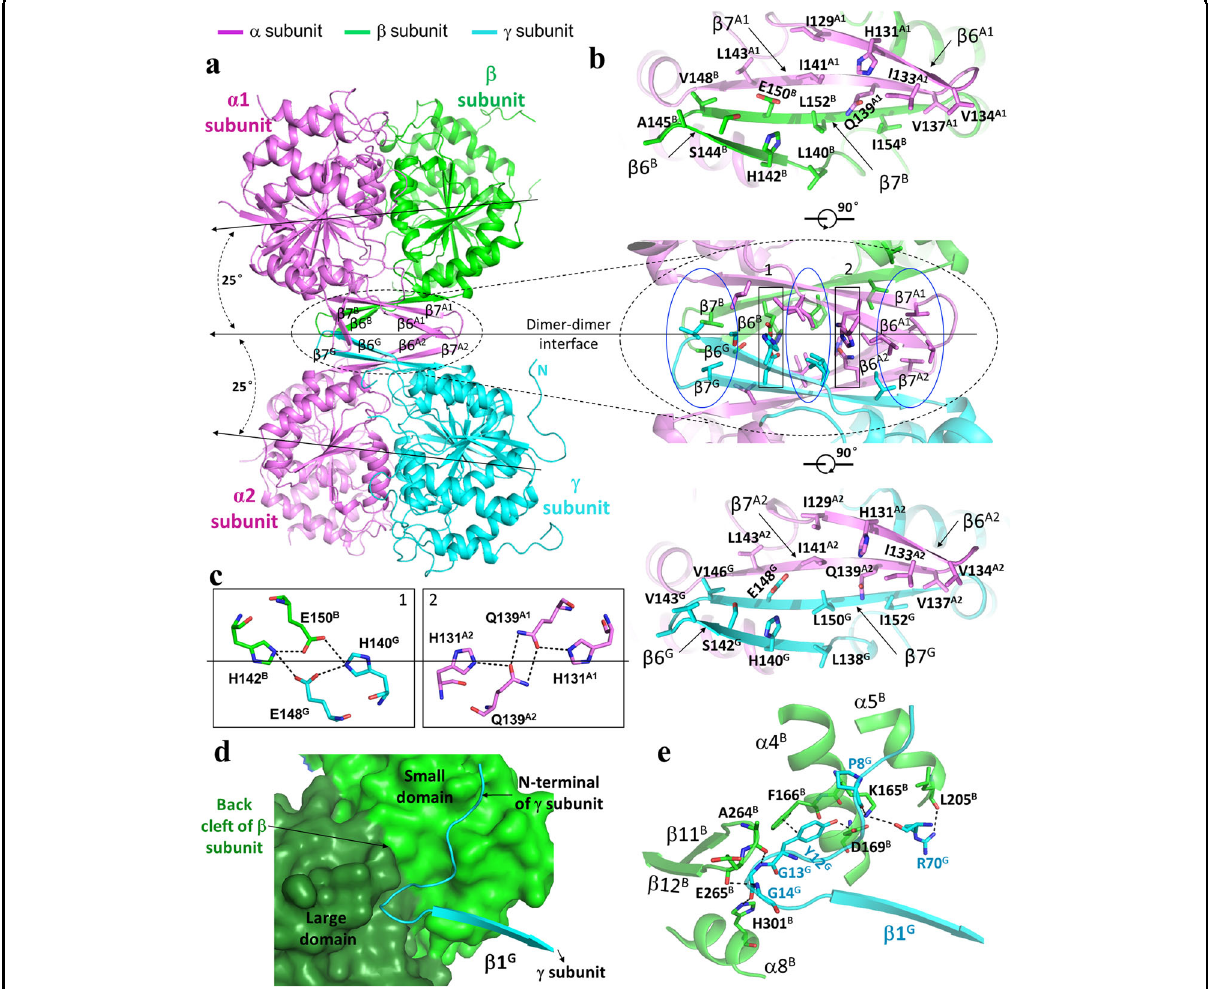
Fig. 2 Interactions at the heterodimer – heterodimer and the heterotetramer – heterotetramer interfaces in the apo β -mutant HsIDH3 structure. a The α 2 βγ heterotetramer is assembled by the αβ and αγ heterodimers via their clasp domains. The color coding of the α , β , and γ subunits is the same as in Fig. 1. The pseudo 2-fold axis along the heterodimer – heterodimer interface, and the coplane axes of the αβ and αγ heterodimers are indicated. b Structure of the heterodimer – heterodimer interface. Middle panel: interactions at the interface consist of largely hydrophobic residues (marked by blue ovals) and a few hydrophilic residues (marked by black rectangles). Upper panel: interactions between the α and β subunits at the interface. Lower panel: interactions between the α and γ subunits at the interface. c Hydrogen-bonding interactions between the β and γ subunits (left panel) and between the two α subunits (right panel). d A surface diagram showing that the N-terminal region of the γ subunit (in cyan ribbon) of one heterotetramer lies in a shallow cleft (the “ back cleft ” ) formed by the small and large domains of the β subunit (in green and dark green surface, respectively) of the other heterotetramer. e Interactions between the γ subunit of one heterotetramer (in cyan) and the β subunit of the other heterotetramer (in green). The hydrogen-bonding interactions are indicated with dashed